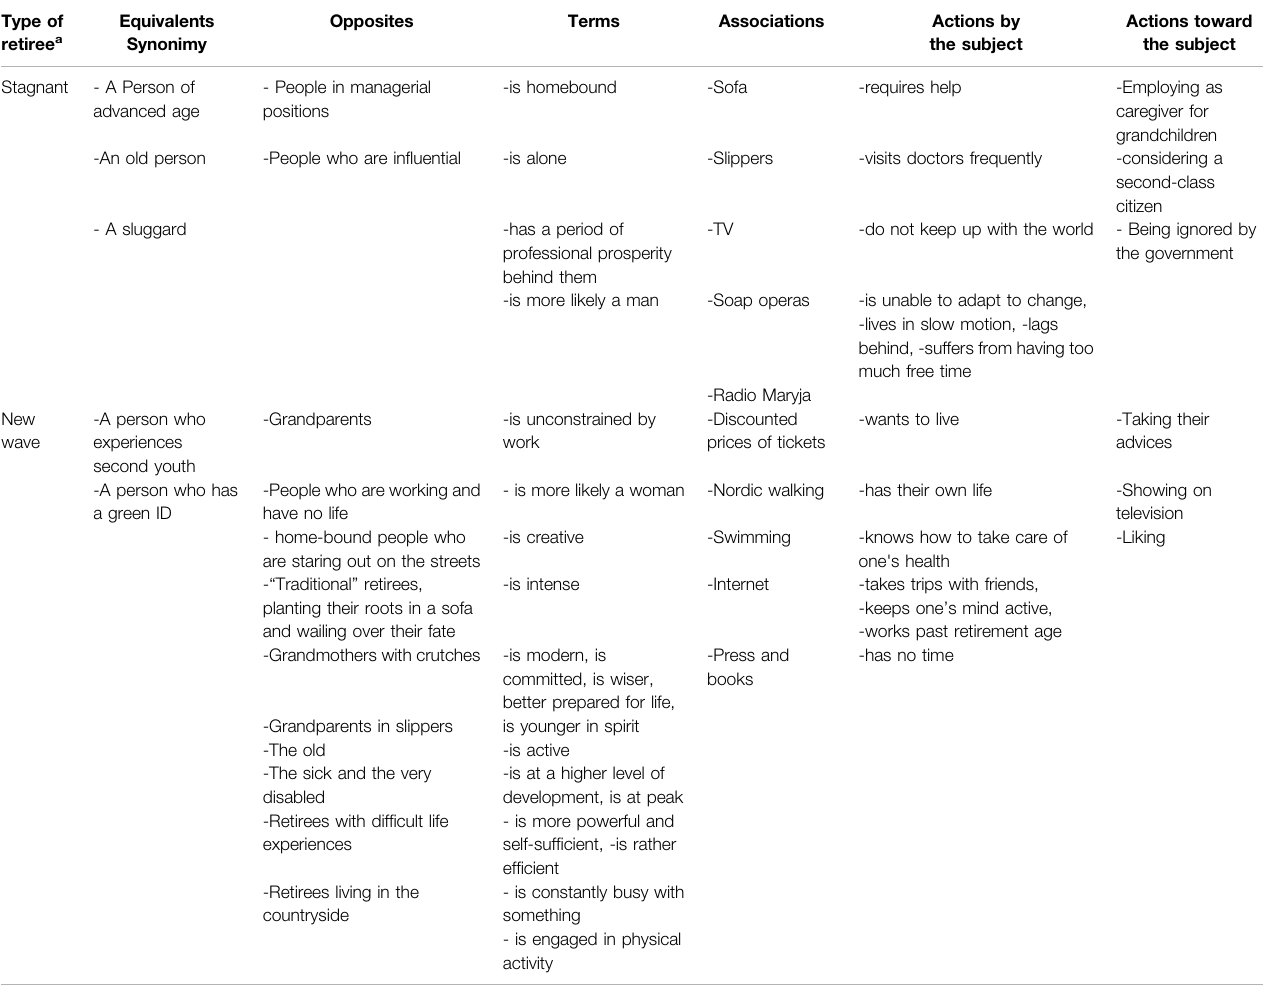
TABLE 3 | Semantic fi eld analysis of term retiree in collected